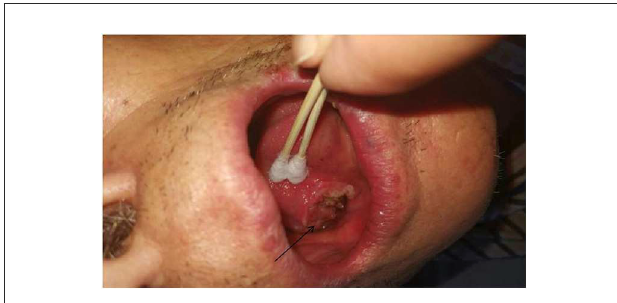
FIGURE1 Glossopharyngeal neuralgia-like symptoms secondary to tongue cancer.